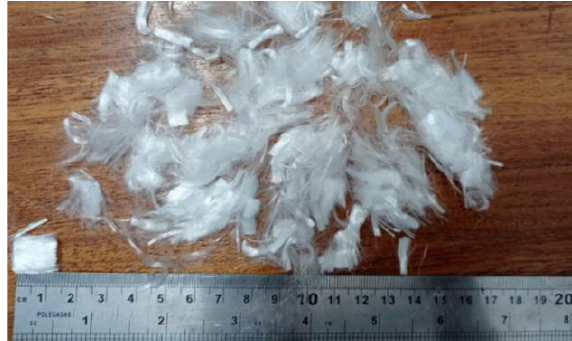
Figure 1. Polypropylene fibers supplied by